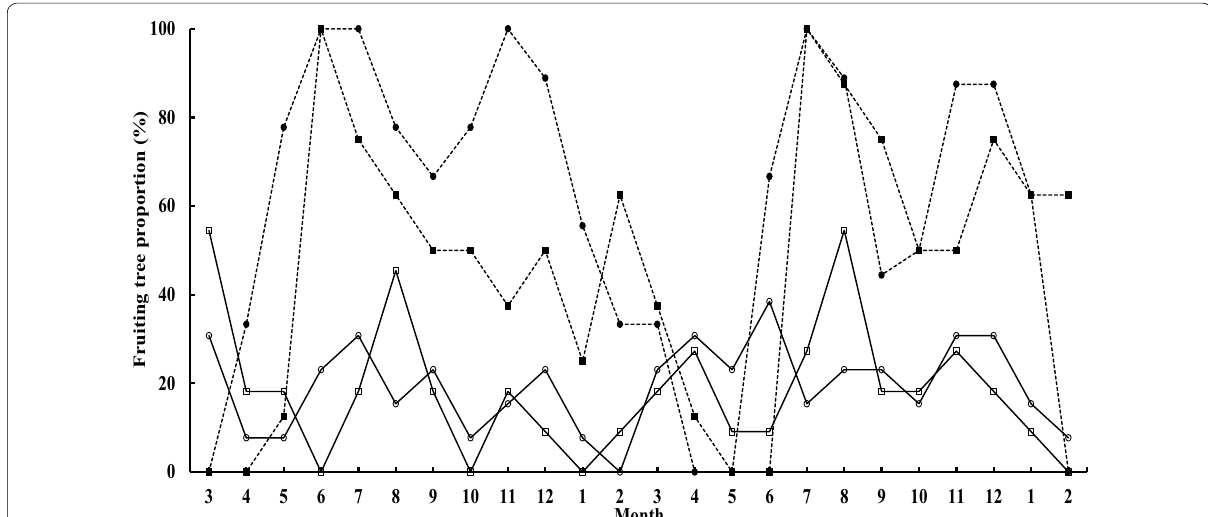
Fig. 1 Fruiting phenology of monoecious (line with open circle: F. caulocarpa ; line with open square: F. subpisocarpa ) and dioecious (line with filled circle: F. ampelas ; line with filled square: F. irisana ) figs by respective fruiting‑tree percentage in the Hengchun Tropical Botanical Garden (HTBC), Kenting